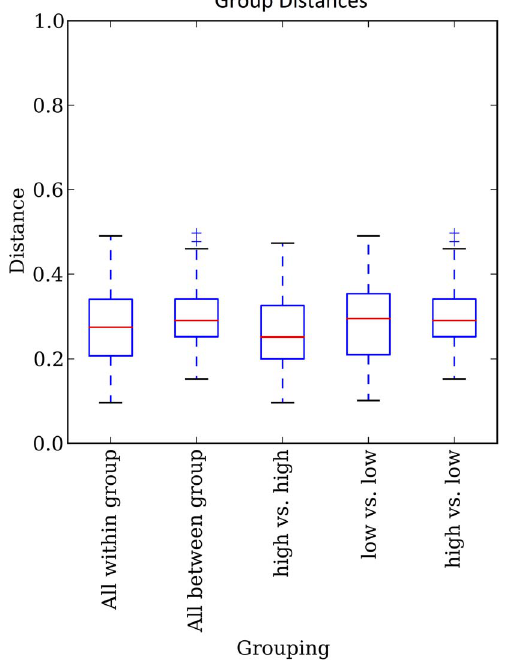
Figure 5. Diversity of the salivary microbiota and if either high or low M18 probiotic persistence had a significant impact. Box plots show weighted UniFrac distances.